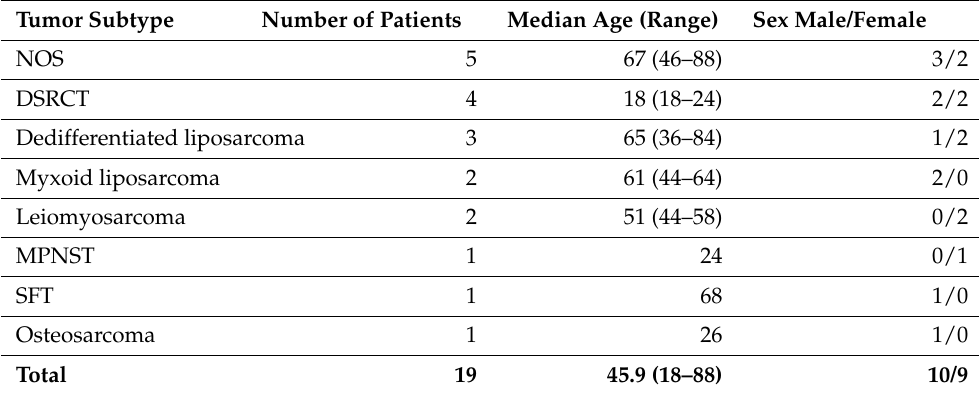
Table 1. Tumor subtypes and patient characteristics.